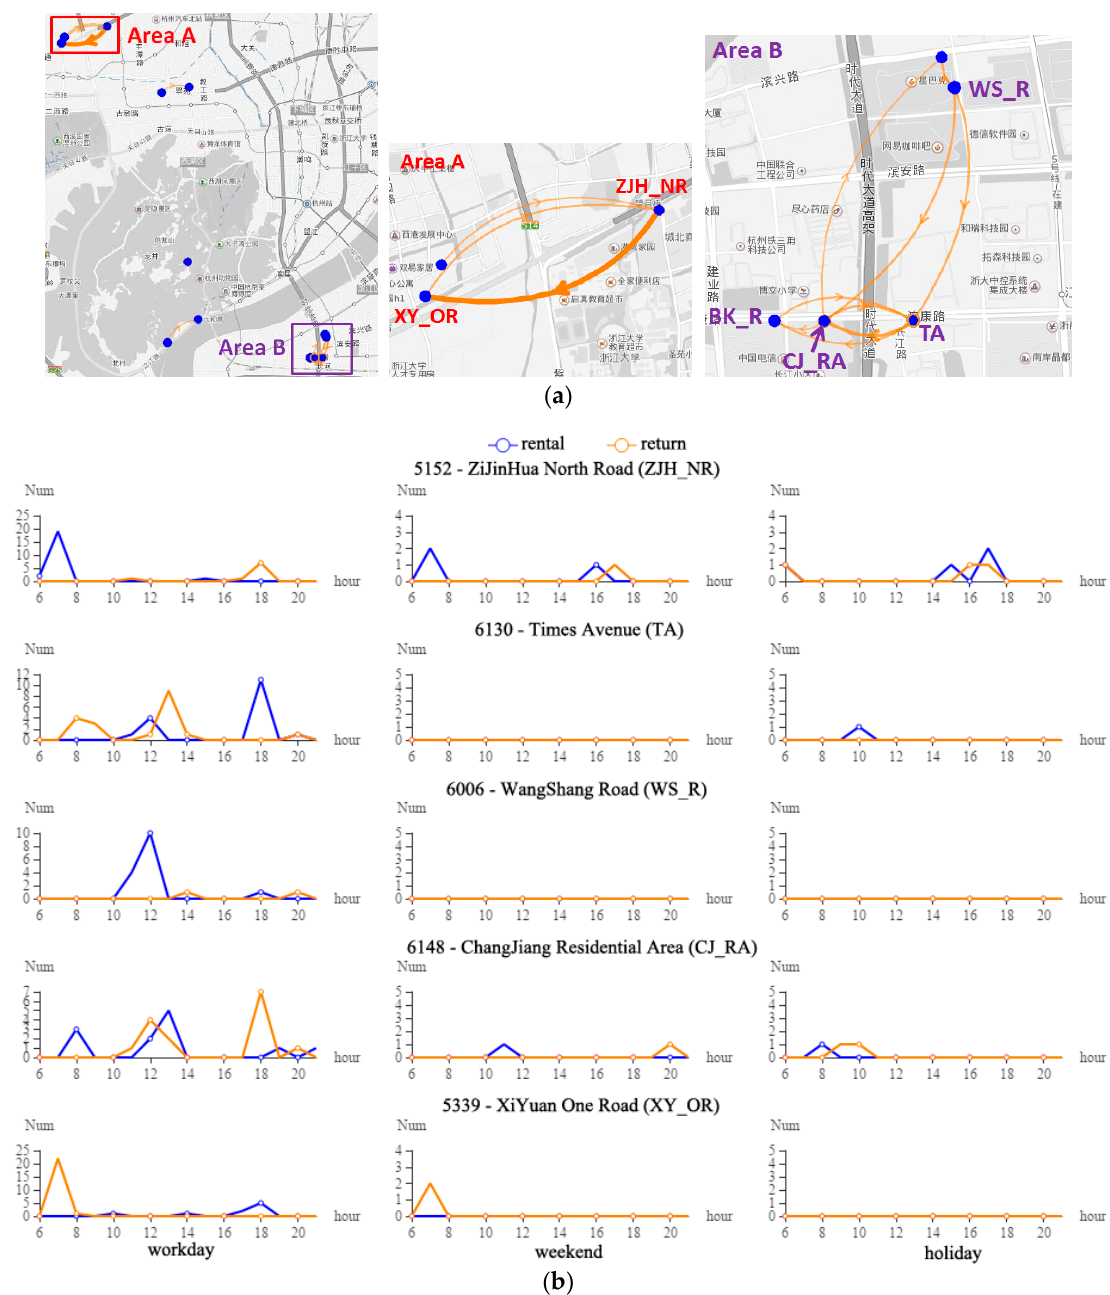
Figure 7. The trajectory aggregation map and station-visited temporal view in example B. ( a ) The trajectory aggregation map; ( b ) The station-visited temporal view.